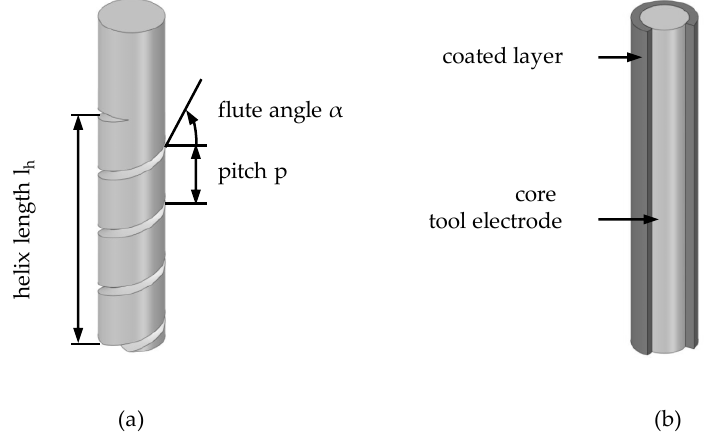
Figure 1. ( a ) Helical tool electrode and ( b ) coated tool electrode.